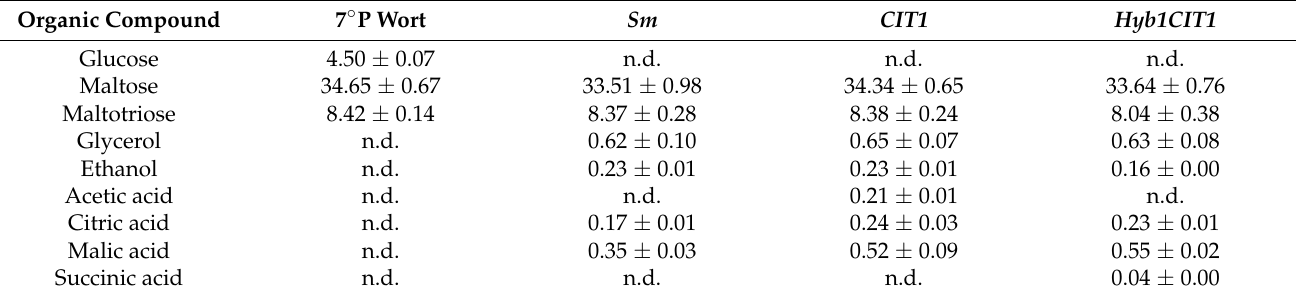
Table 6. Organic compounds (g L − 1 ) in final beers ( Sm , CIT1 and Hyb1CIT1 ) produced from 7 ◦ P